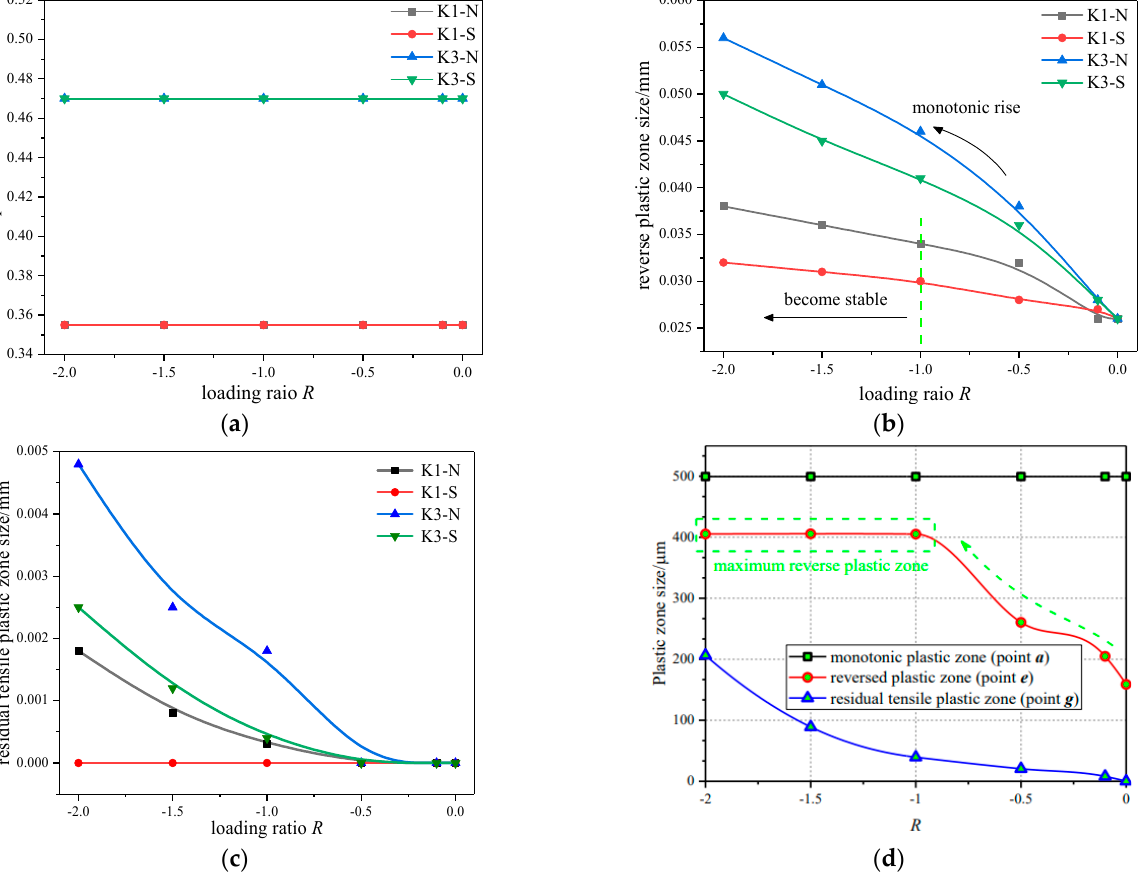
Figure 14. Relationships of plastic zones: ( a ) Monotonous plastic zone; ( b ) Reversed plastic zone; ( c ) Residual tensile plastic zone; ( d ) Results in the paper [18].